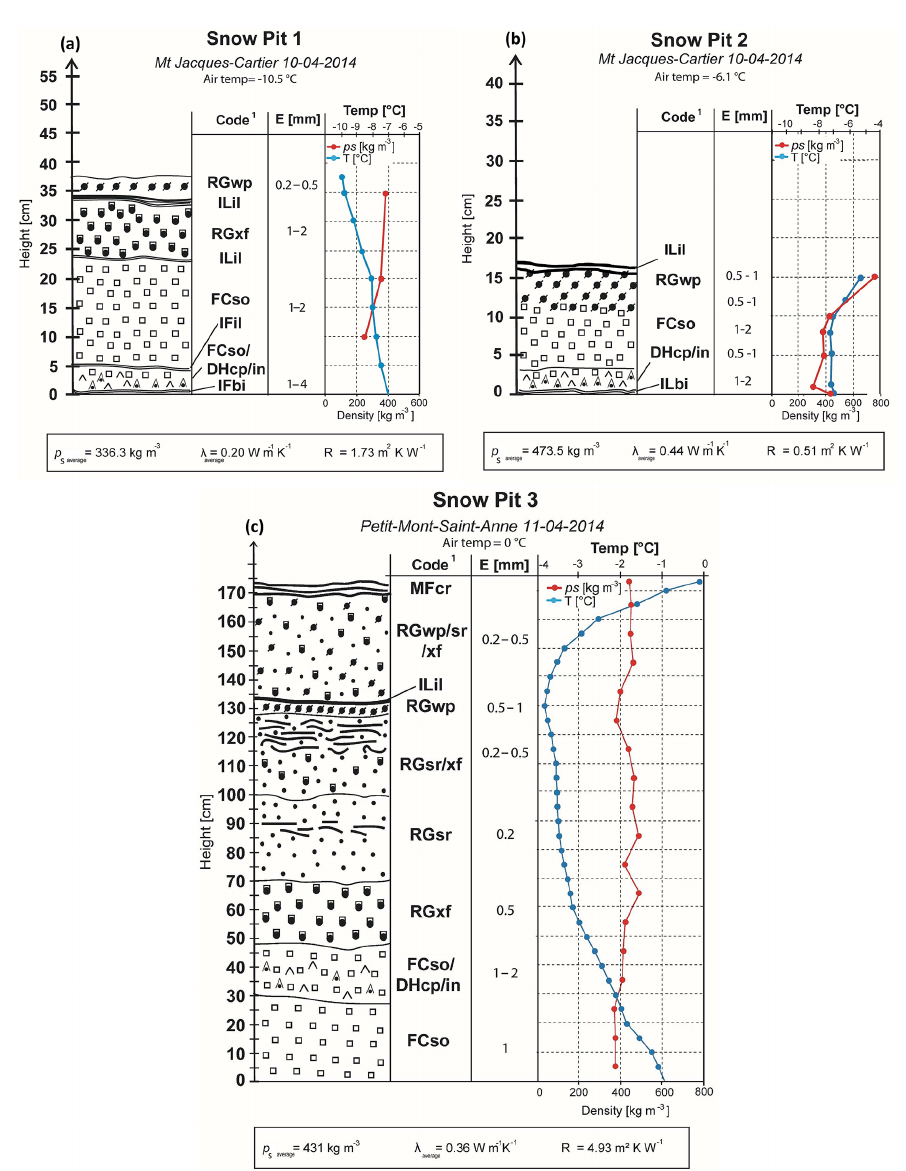
Figure 5. Snow stratigraphy interpreted from profiles excavated in snowpacks on the tundra areas of Mont Jacques-Cartier ( a and b ) and on a krummholz patch on the Petit Mont Saint-Anne summit (c) in April 2014. Code: RGwp: wind-packed rounded grains; RGsr: small rounded grains; RGxf: faceted rounded particles; FCso: solid faceted crystals; MFcr: melt–freeze crust; DHcp: depth hoar, hollow cups; ILil: horizontal ice layer (Fiez et al., 2009). DHin: indurated depth hoar, as defined in Domine et al. (2016b), whose symbol combines a depth hoar symbol with a small rounded grain symbol, has been used here. ρ s (kgm − 3 ) , λ (Wm − 1 K − 1 ) , and R (m 2 KW − 1 ) represent, respectively, the density, the thermal conductivity, and the thermal resistance of the snowpack. The ρ s and λ for the snow pits are the average of values measured for each layer of the